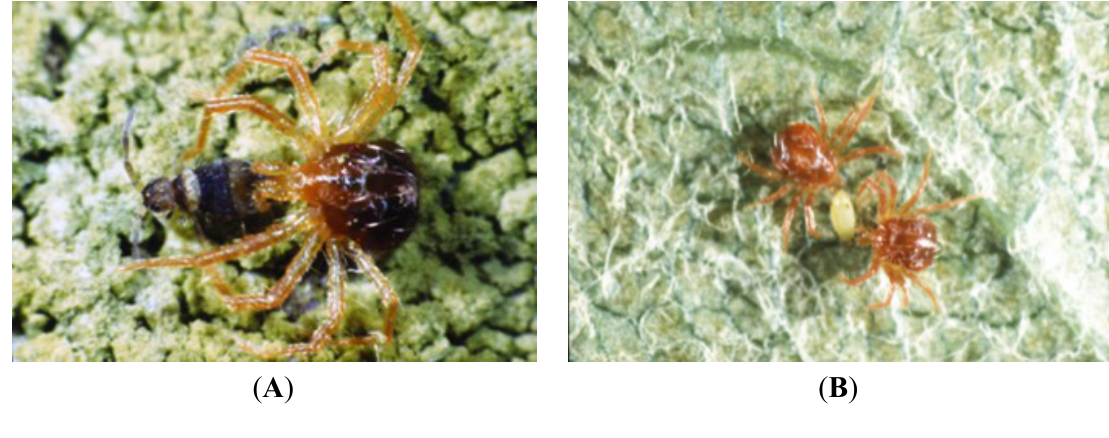
Figure 11. Anystis baccarum attacking ( A ) Collembola and ( B ) apple-grass aphid prey (Photos: Andrew G. S. Cuthbertson ©